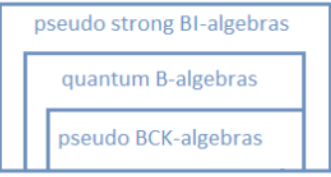
Figure 3. The relationships among some algebraic